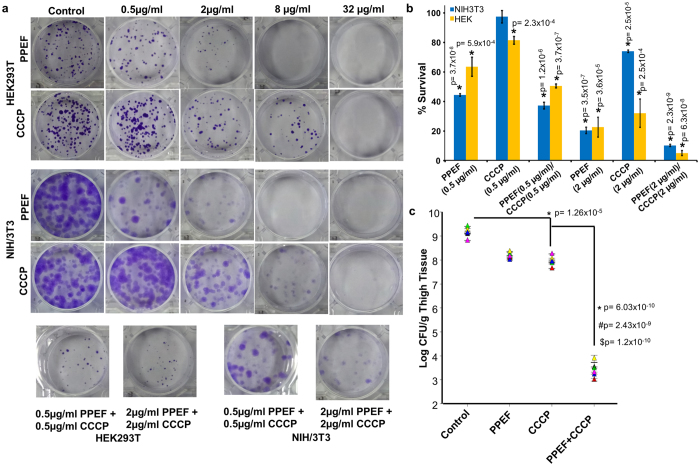
In vitro and In vivo efficacy of PPEF, CCCP and combination therapy.(a) Representative image of plates showing stained colonies treated with PPEF and CCCP alone and in combination for 24 h. (b) % Cell viability of NIH/3T3 and HEK293T cells in presence of indicated concentrations of PPEF, CCCP and PPEF + CCCP. Experiments are presented as mean ± SD (n = 3). Statistical analysis was done by one way ANOVA followed by two tailed ‘t’ test. Asterisks (*) indicates statistical significance and (*P ≤ 0.05) values are considered significant. Detailed statistically significant p-values of control vs. experimental are indicated. (C) In vivo efficacy of PPEF 3 mg/kg.bw, CCCP 3 mg/kg.bw and PPEF 3 mg/kg.bw + CCCP 3 mg/kg.bw in mice neutropenic thigh infection model. Graph represents Log10 CFU/g thigh vs drug dose in Balb/c mice. Asterisks (*) indicates statistical significance and (*P ≤ 0.05) with n = 6 animals in each group. Detailed statistically significant p-values are described below: control vs PPEF 0.8204, control vs CCCP 0.0000126, control vs PPEF + CCCP 0.000000000603, CCCP vs PPEF + CCCP 0.00000000243, PPEF vs PPEF + CCCP 0.000000000120.